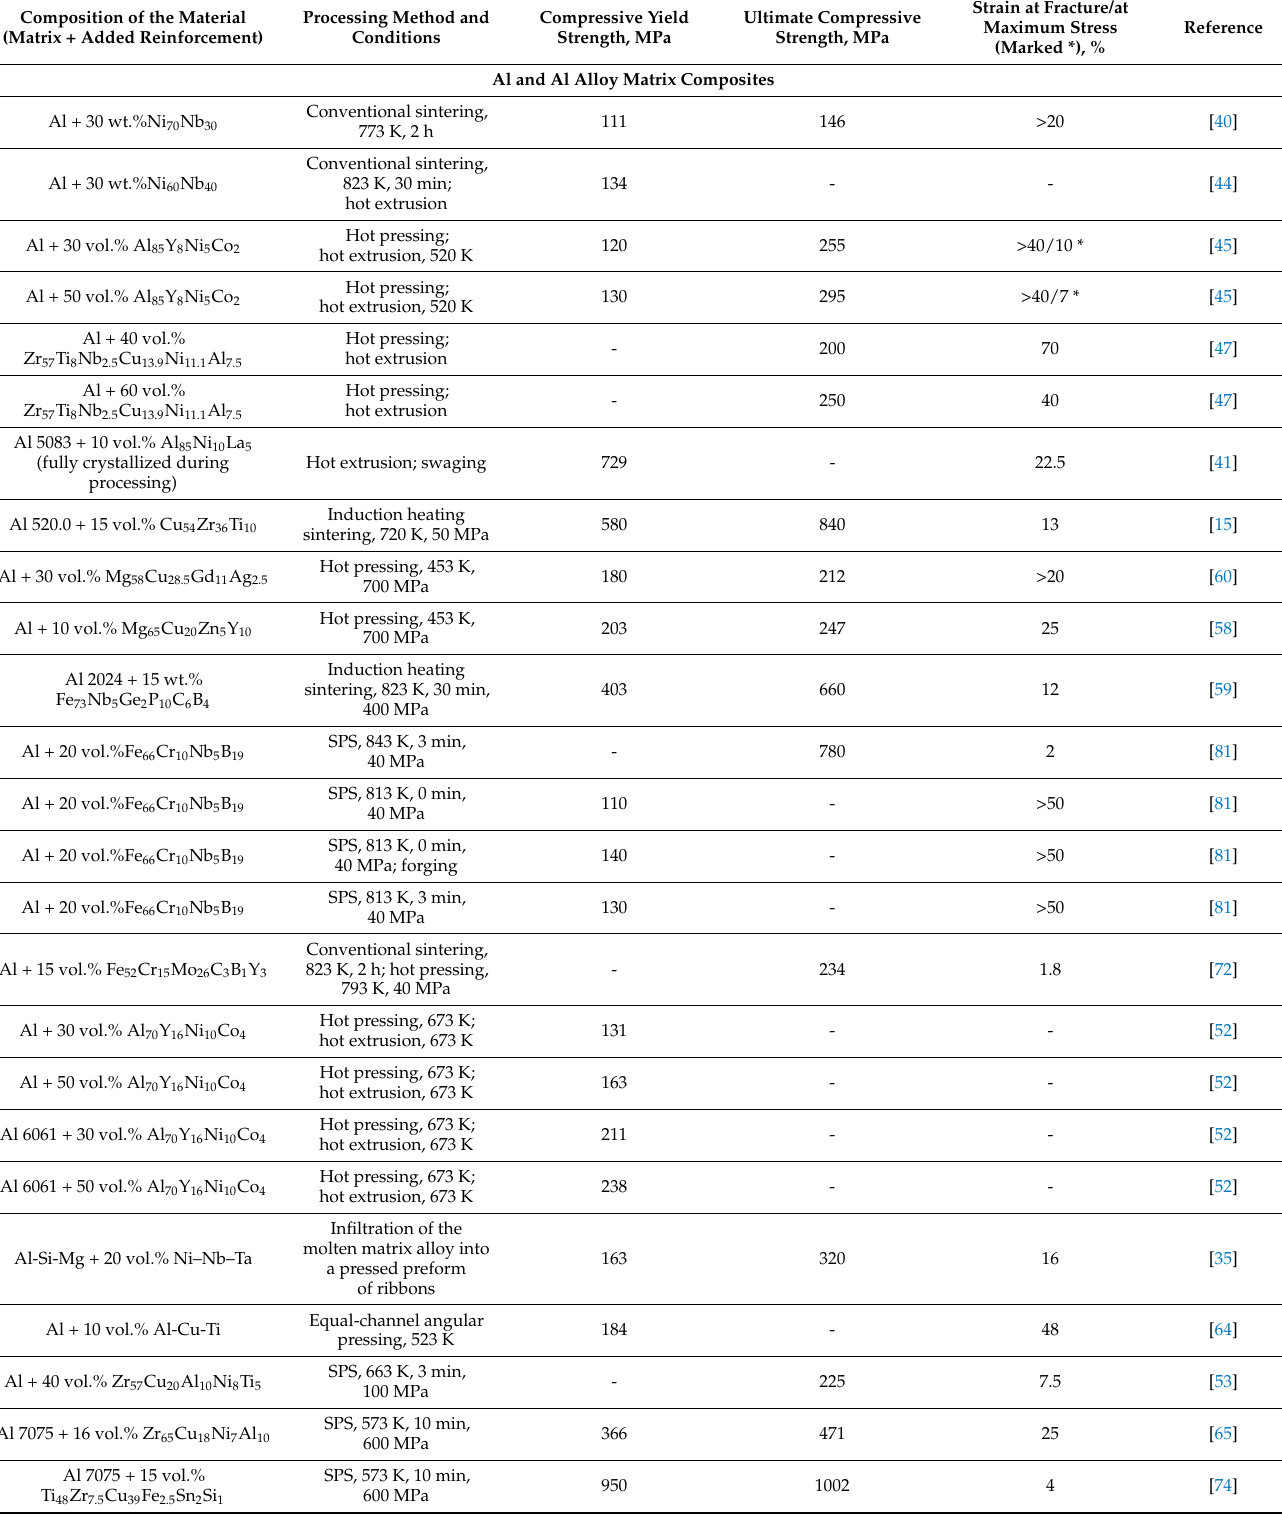
Table 4. Mechanical properties of selected metallic glass (amorphous alloy) particle-reinforced MMCs in